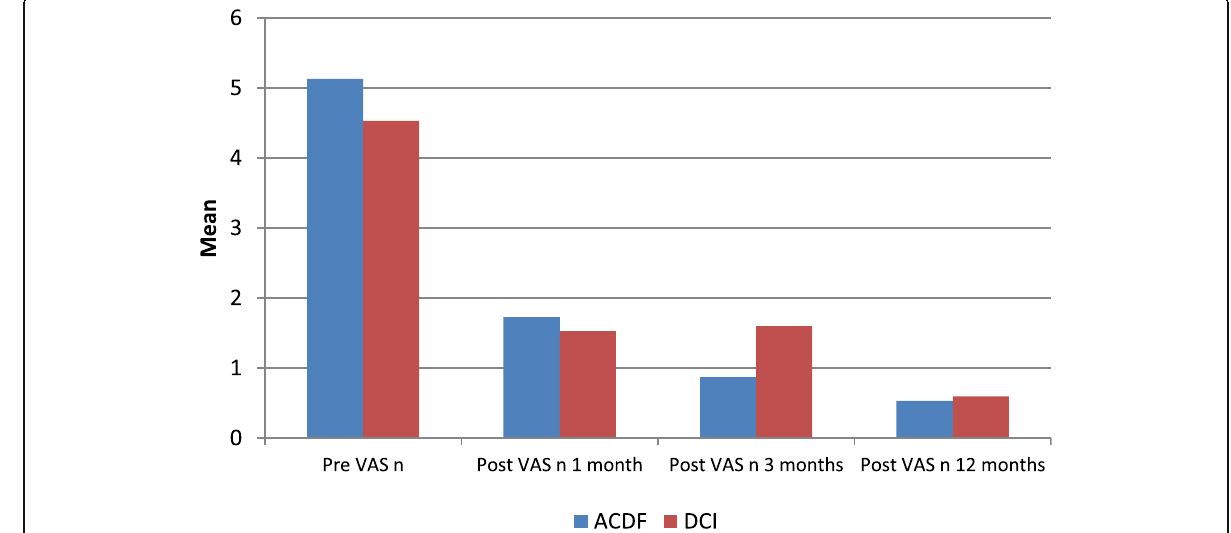
Fig. 1 Visual analogue score for the neck pain recorded preoperatively, and at 1, 3, and 12 months postoperatively for both